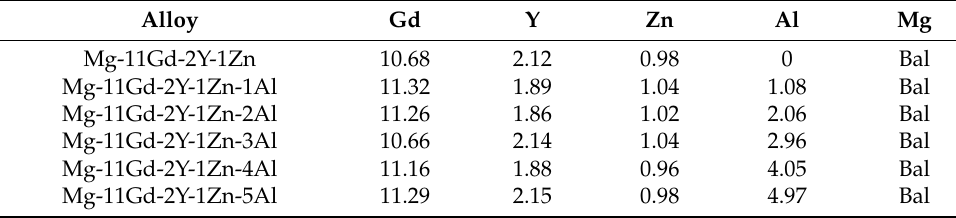
Table 1. Actual chemical compositions of experimental alloys (wt.%).